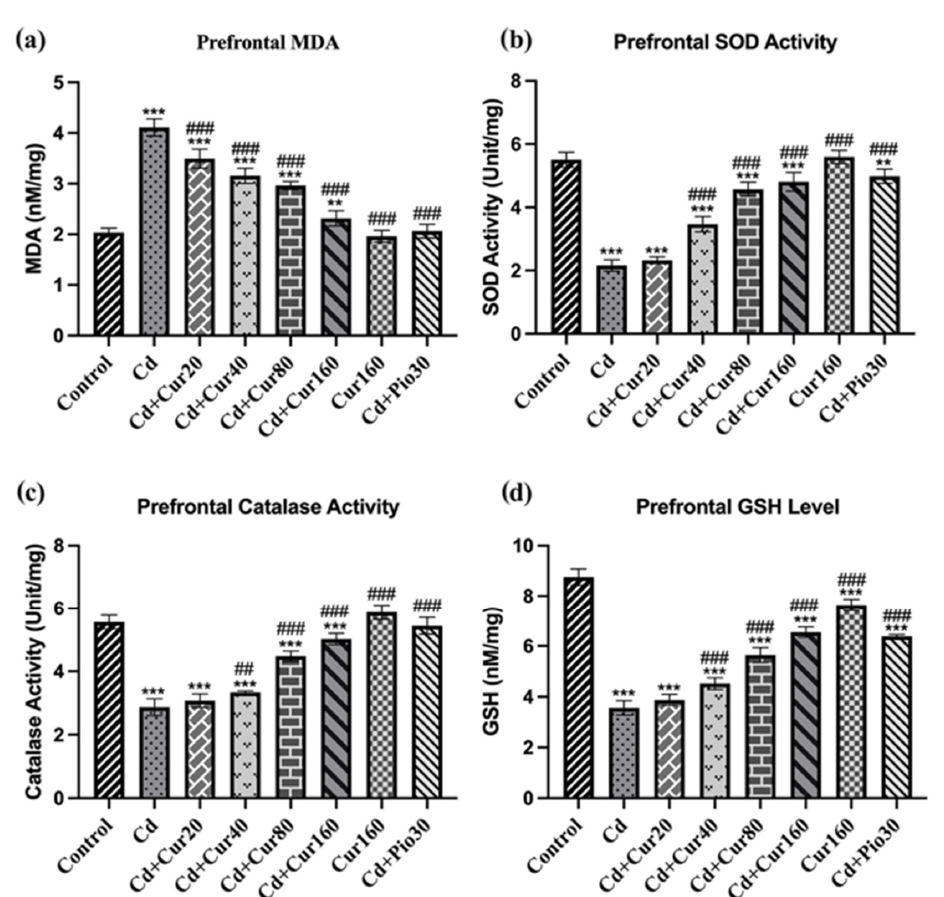
Figure 5. Effect of curcumin on Cd exposed mice showing oxidative stress; ( a ) MDA ( b ) SOD ( c ) CAT and ( d ) GSH. Each column represents the mean ± SEM of 7 animals. One-way ANOVA followed by Dunnett’s post-test; * p < 0.05, ** p < 0.01 and *** p < 0.001 showing significant differences between control and treatment group. ## p < 0.01 and ### p < 0.001 and showing significant differences between Cd exposed group and curcumin treated groups.